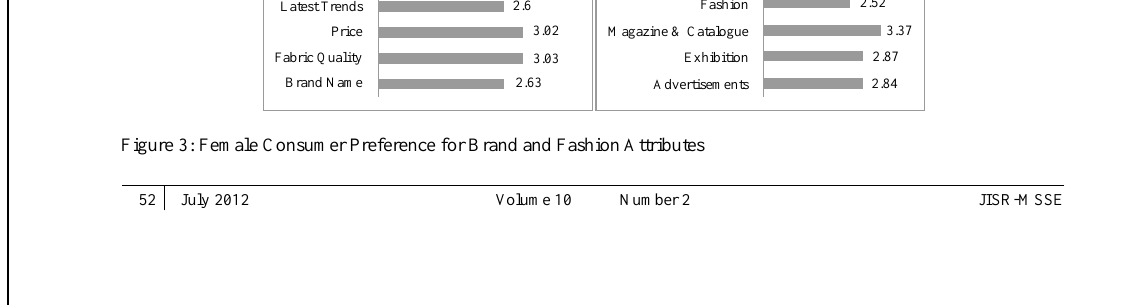
Female Consumers Preferences for Fashion Attributes